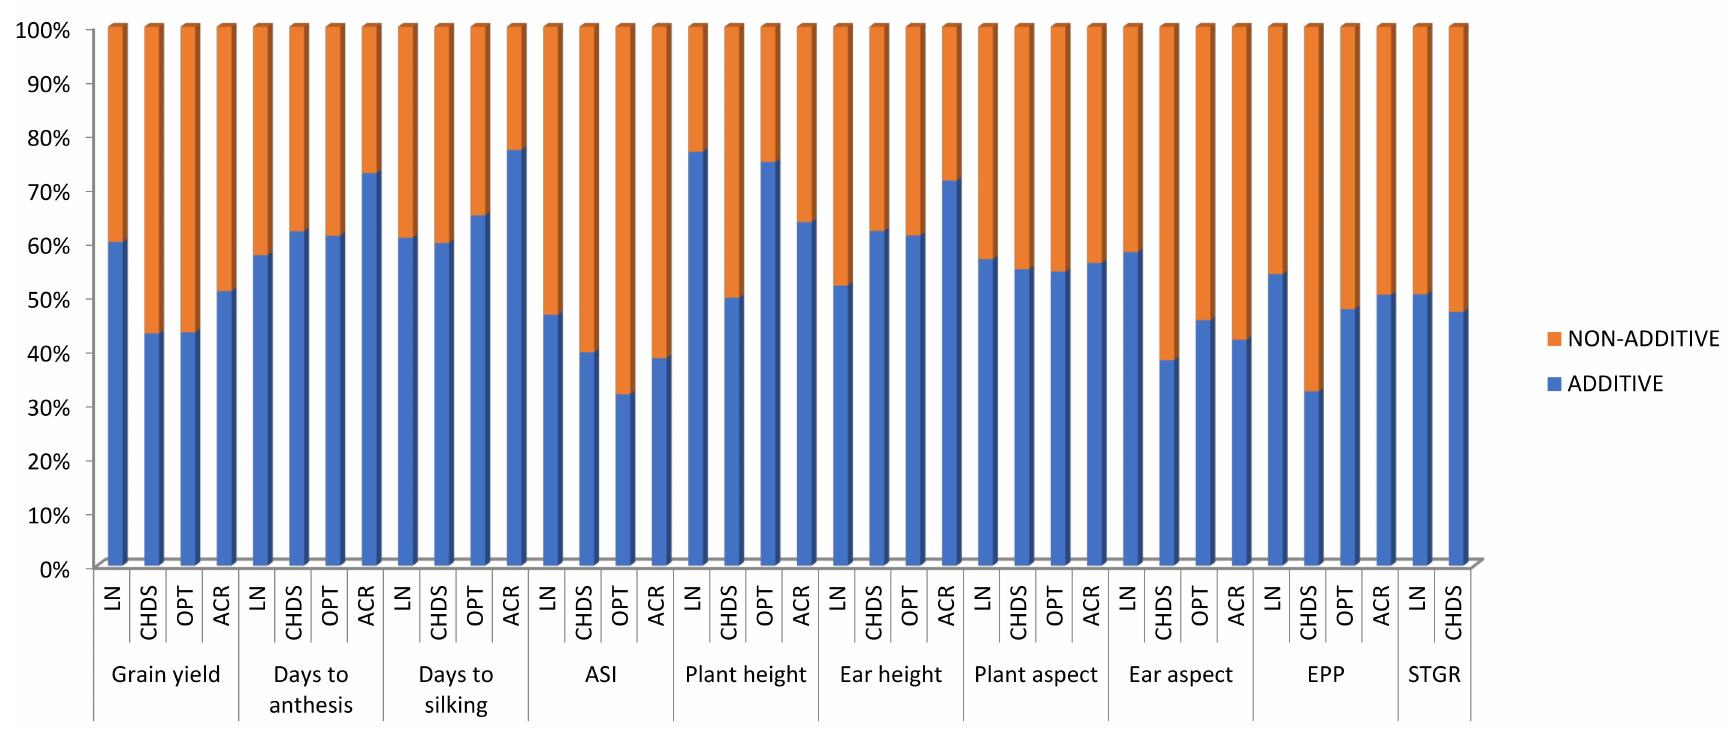
Figure 1. Proportion of additive and non-additive genetic variances for grain yield and other agronomic traits under low-nitrogen, CDHS, optimal conditions and across test